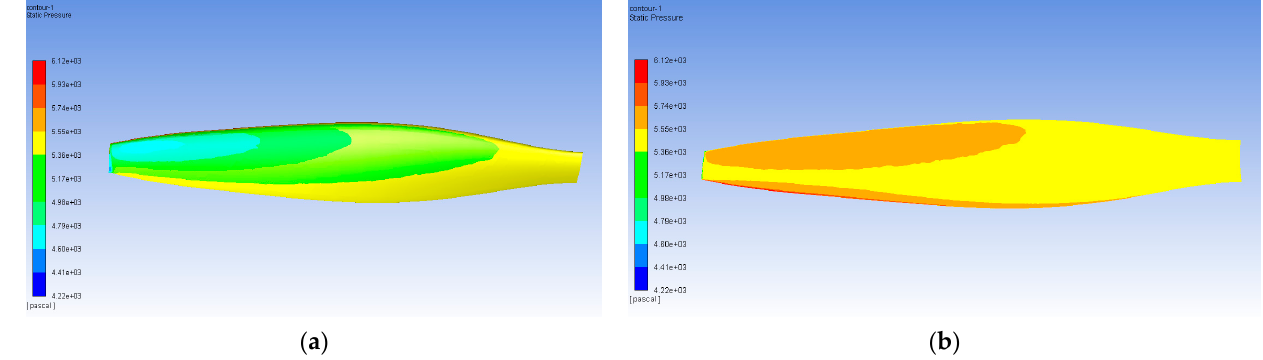
Figure 17. Pressure contour of the propeller at the design point: ( a ) upper surface of the blade; ( b ) lower surface of the blade.